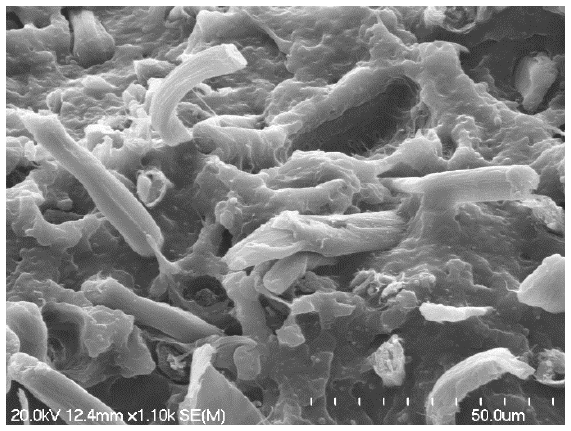
Figure 15. Fiber fracture seen in 20 wt % harakeke filament.